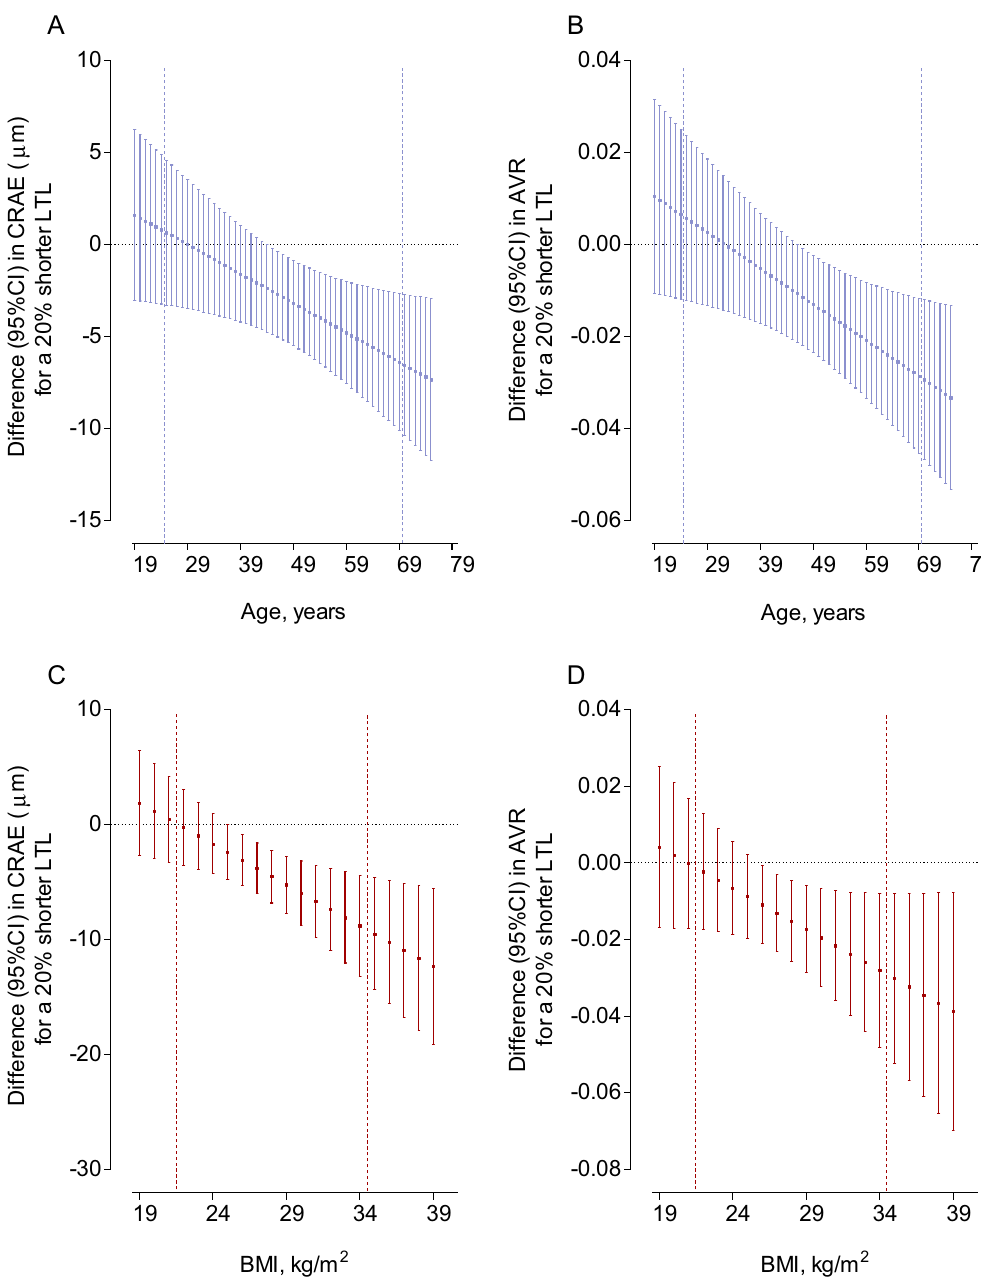
Figure 1. Effect size of the association of CRAE and AVR with average relative leukocyte telomere length (LTL) in men according to the age range ( A and B ) and BMI range ( C and D ). Effects presented as a difference in arteriolar (CRAE) diameter in μ m or as the difference in arteriole-to-venule ratio (AVR) for a 20% shorter LTL. Models adjusted for age, sex, systolic blood pressure, smoking status, BMI as fixed effects and adjusted for participants nested within a family cluster as random effect. Dashed vertical lines indicates boundaries of 5th–95th percentile of age or